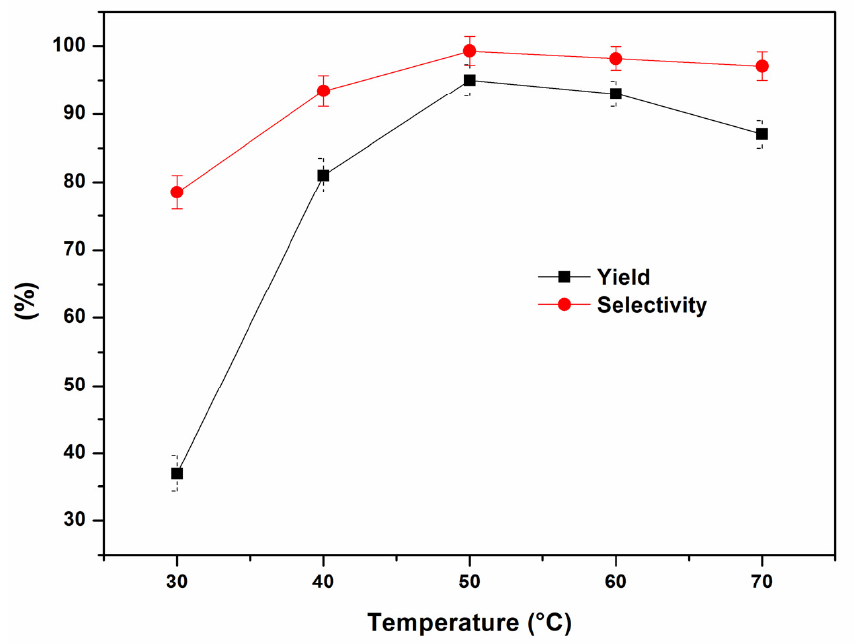
Figure 3. Effect of reaction temperature on the reaction. Reaction conditions: 2-methylaziridine (10 mmol), MCM-41@ILLaCl 4 (5%, weight percent based on 2-methylaziridine), CO 2 (0.7 MPa), 3 h.